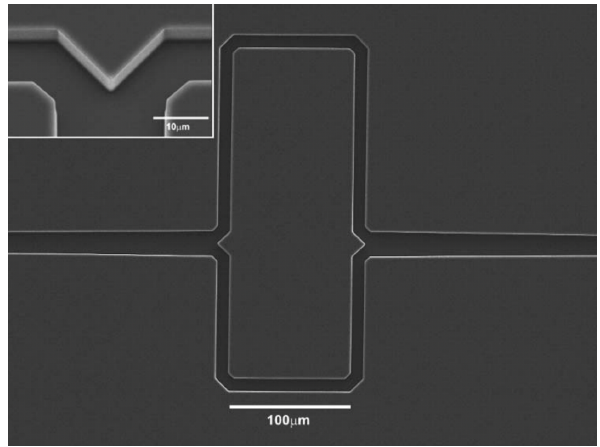
Figure 25. Recent approaches to achieve OMLoC RI detection with an ARROW-based MZI. Reprinted with permission from [148] © (2010) The Optical